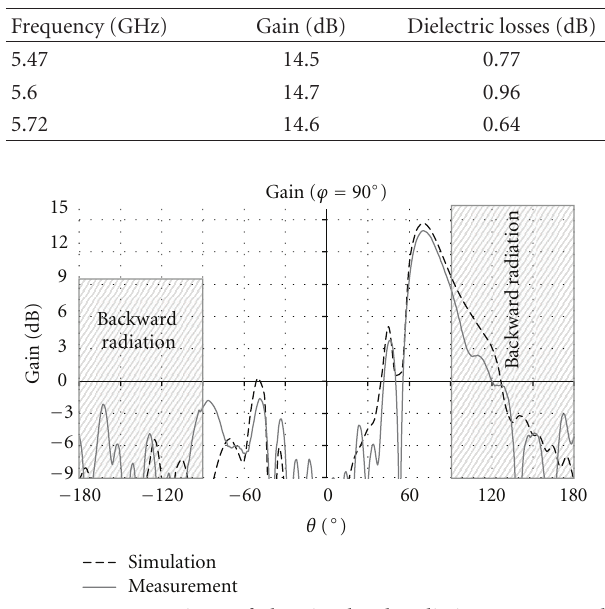
Figure 9: Comparison of the simulated radiation pattern and measurement at f = 5.6 GHz.